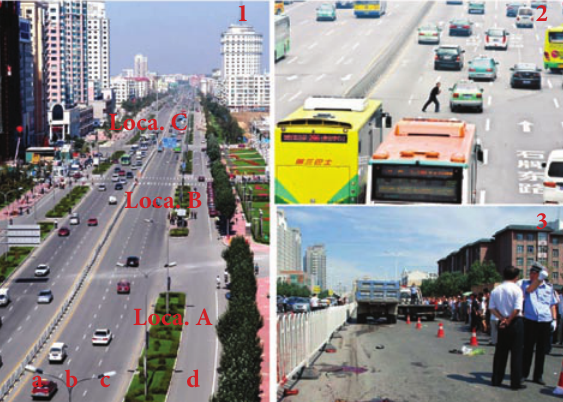
Fig. 5. Higher risk road identification prone to